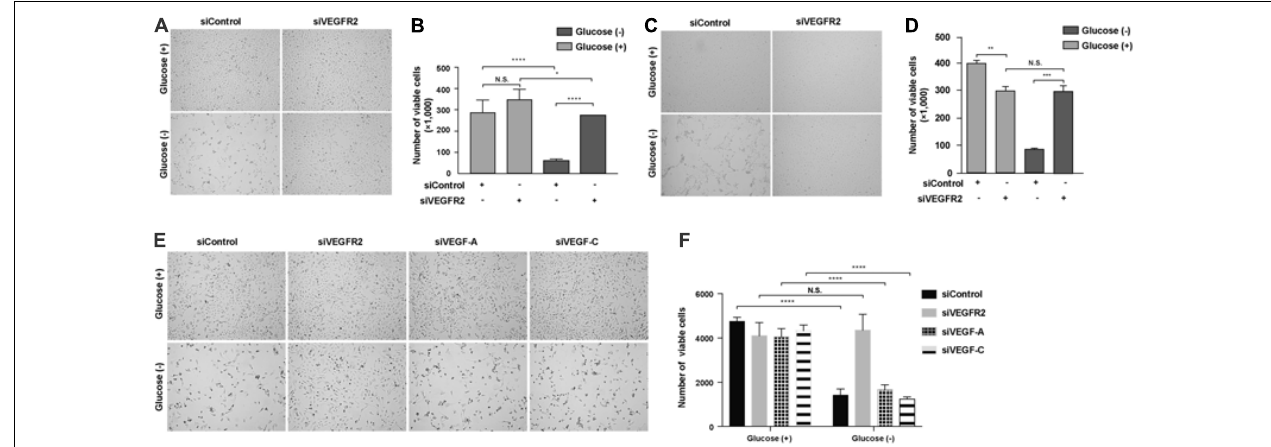
FIGURE 1 | Depletion of VEGFR2 and not of its ligands VEGF-A or VEGF-C rescued glucose-depletion-mediated cell death in RPE cells. (A) Glucose depletion resulted in cell death, and VEGFR2 knockdown by siRNA rescued it in primary hRPE cells. (B) Quantification of (A) . (C) Glucose depletion resulted in cell death, and VEGFR2 knockdown rescued it in ARPE-19 cells. (D) Quantification of (C) . (E) Different from knockdown of VEGFR2, knockdown of VEGF-A and VEGF-C could not rescue the cell death caused by glucose depletion. (F) Quantification of (E) . Data in (D,E) are the means of three independent experiments ( n = 3). All error bars indicate S.D. * P < 0.05, ** P < 0.01, *** P < 0.001, **** P < 0.0001.